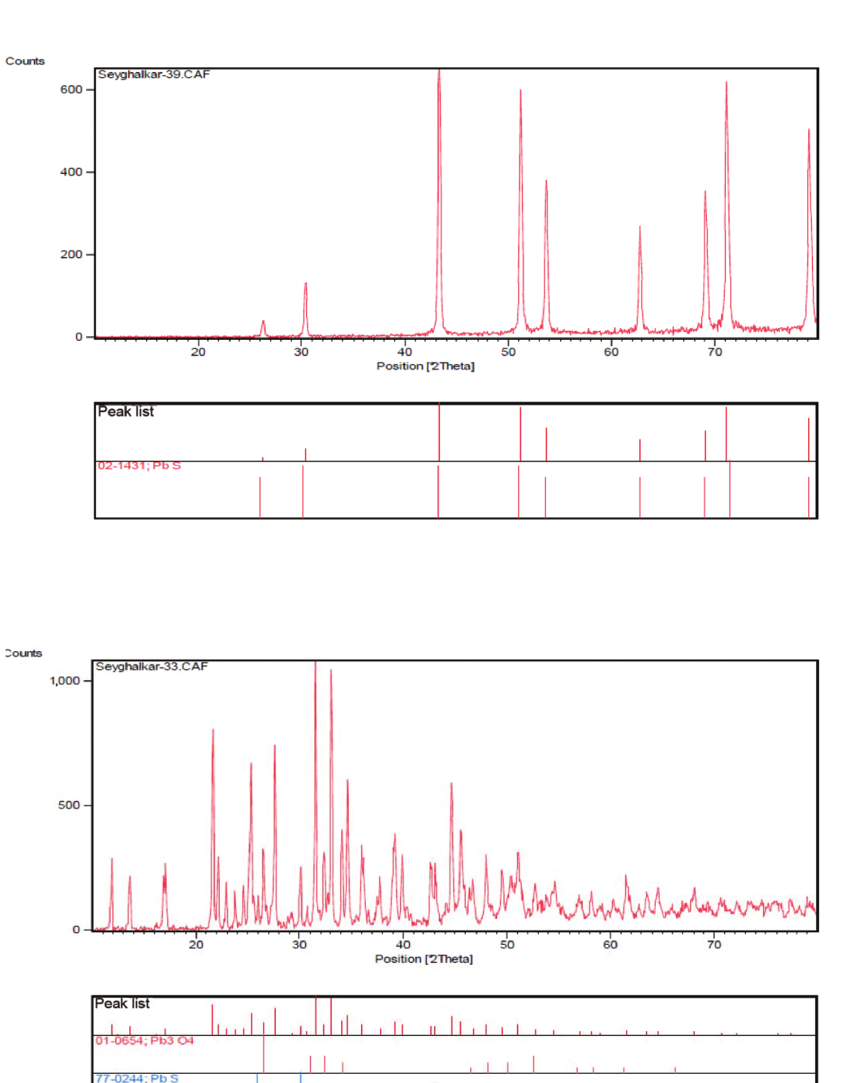
Figure 2: XRD pattern of sample no. 2.